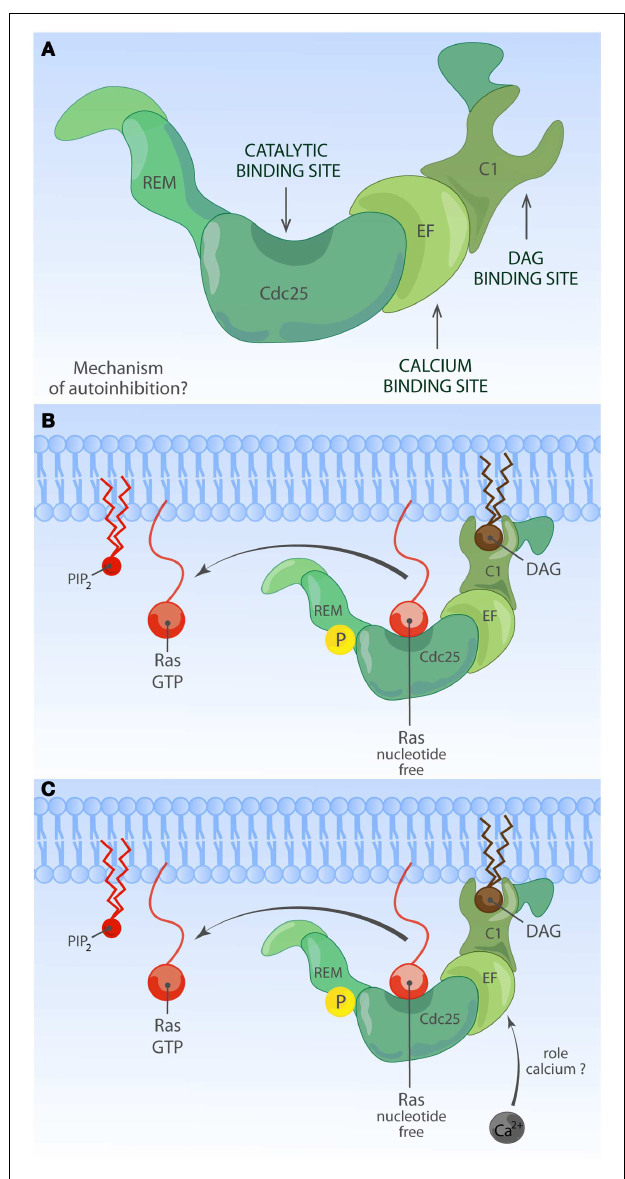
FIGURE 4 |Activation of RasGRP . (A) Depiction of RasGRP with its protein domains. RasGRPs must be controlled to prevent spurious Ras activation but the exact mechanism of auto-inhibition is unknown. Roles for various domains C-terminal of the Cdc25 domain to limit membrane recruitment of RasGRP have been proposed. (B) DAG-regulated membrane recruitment of RasGRP. Receptor-induced generation of diacylglycerol (DAG) results in efficient membrane recruitment on RasGRP1, RasGRP3, and RasGRP4 where these RasGEFs can encounter Ras · GDP to activate it to Ras · GTP. RasGRP1 and RasGRP3 are known to be phosphorylated on a conserved threonine residue at the very start of the Cdc25 domain, which enhances their catalytic activity through an unknown mechanism. RasGRP2 does not efficiently bind DAG and must have a different membrane-recruiting mechanism. (C) Other regulatory mechanisms for RasGRP. Amino acid sequence homologies predict that RasGRPs lack and allosteric Ras-binding pocket as the one observed for SOS. RasGRP proteins contain EF hands, structure that can often bind calcium. Calcium has been implicated in the recruitment of RasGRP1 to the membrane but nuances appear to exist in different cell types. It is not known if other lipid moieties such as PIP 2 can regulate the activity or residence time of RasGRP1 at the